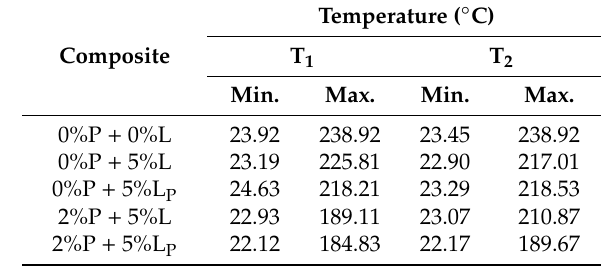
Figure 11. Flame temperature curves for the distribution of measuring points along the horizontal (1) and vertical (2) curves (T 1 and T 2 ) from the thermographic camera.